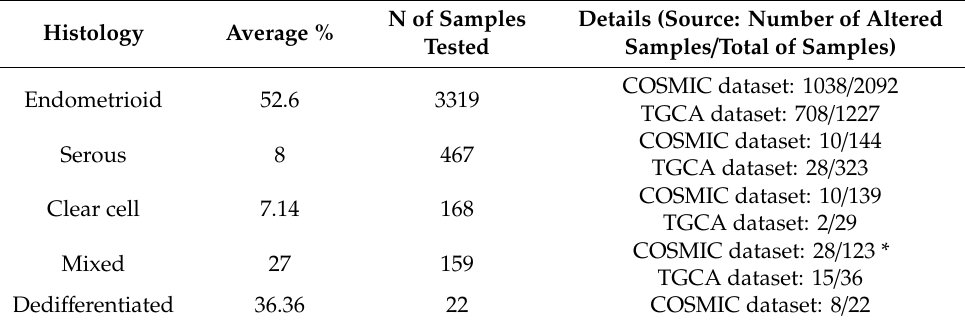
Table 2. Incidence of PTEN alterations in endometrial cancer.